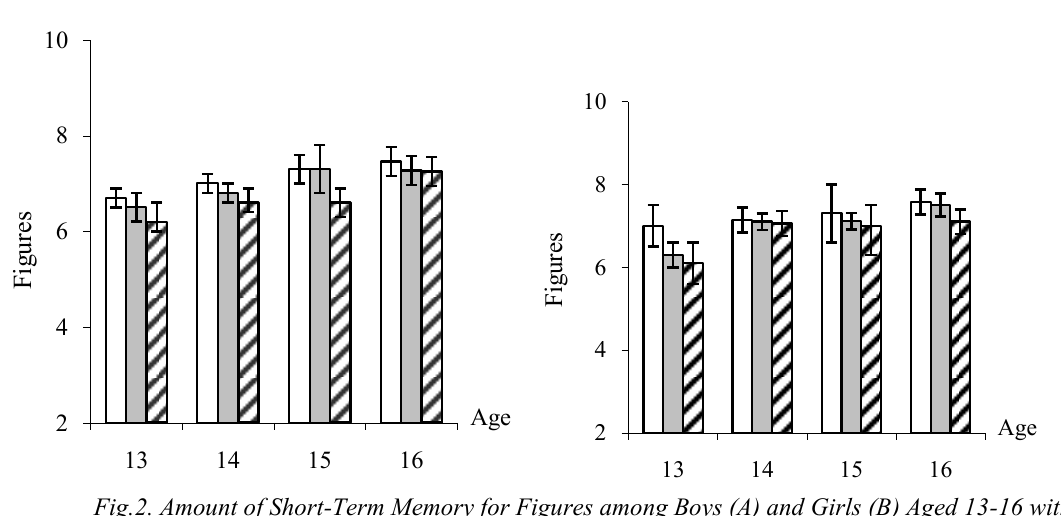
Fig.2. Amount of Short-Term Memory for Figures among Boys (A) and Girls (B) Aged 13-16 with - High, - Middle, - Low Level of Physical Development * - the reliability of differences between high and low level of physical development р<0.05